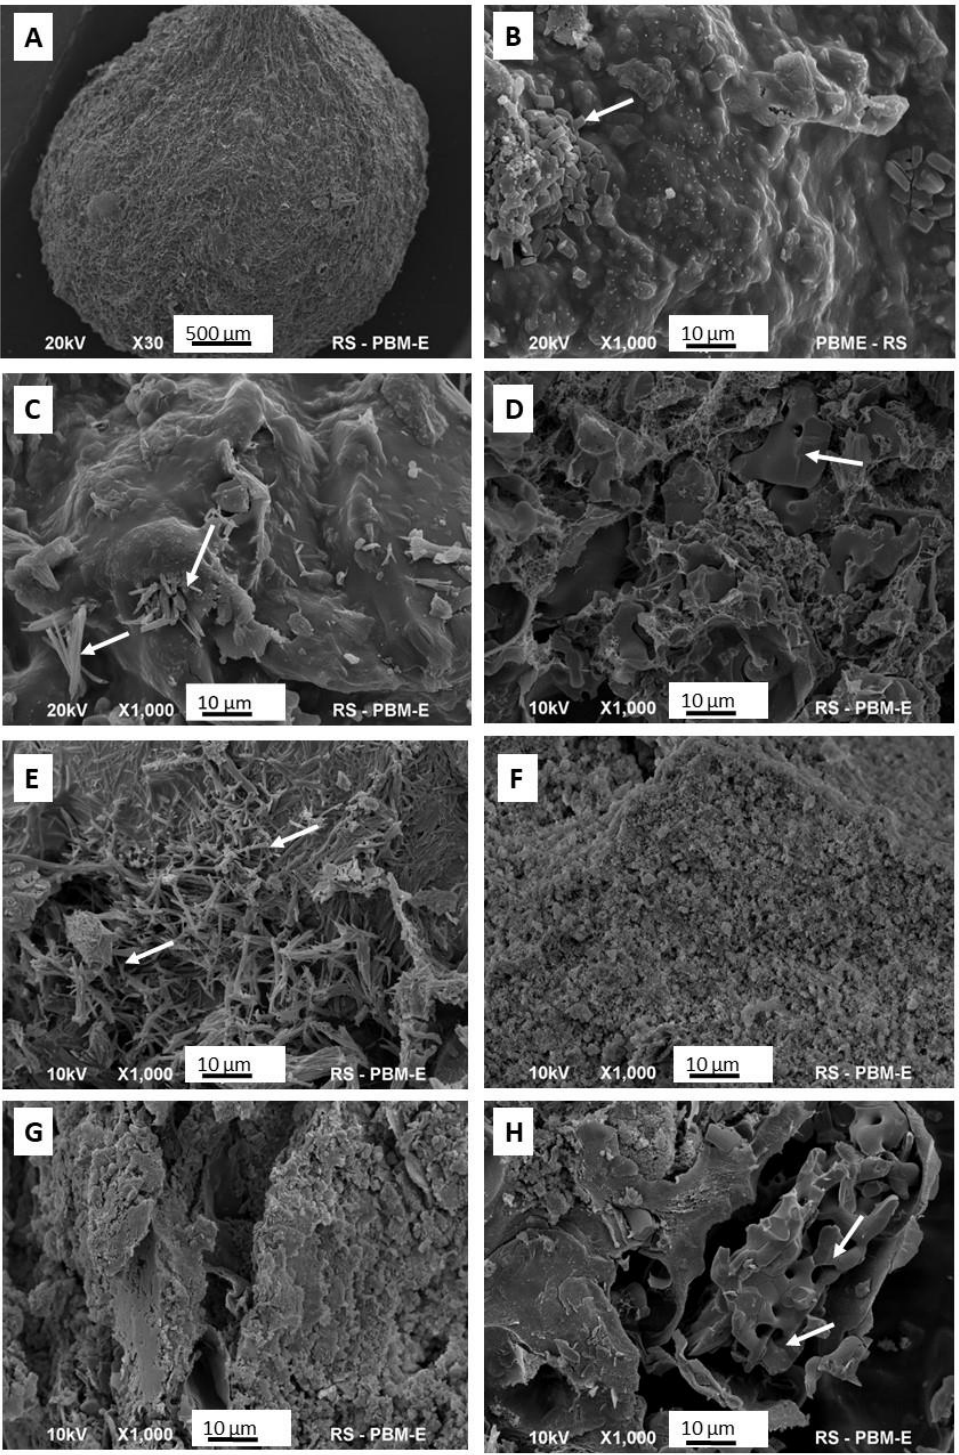
Figure 4. SEM representative images of the granules: ( A ) the outer surface of the granule; ( B – H ) internal cross-sections of granules G1–G7. The arrows indicate the crystals of calcium phosphates.